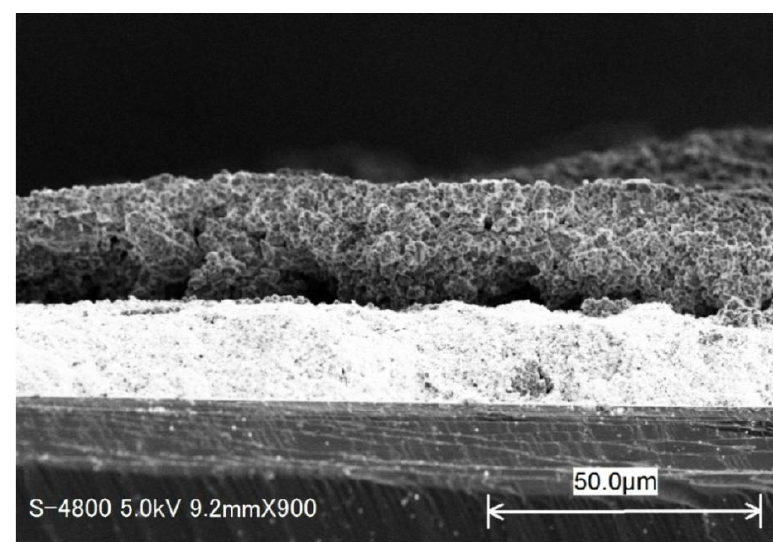
Figure 3. SEM images of ( a ) MFI-S; ( b ) MFI-70; ( c ) MFI-150 and ( d ) MFI-470.